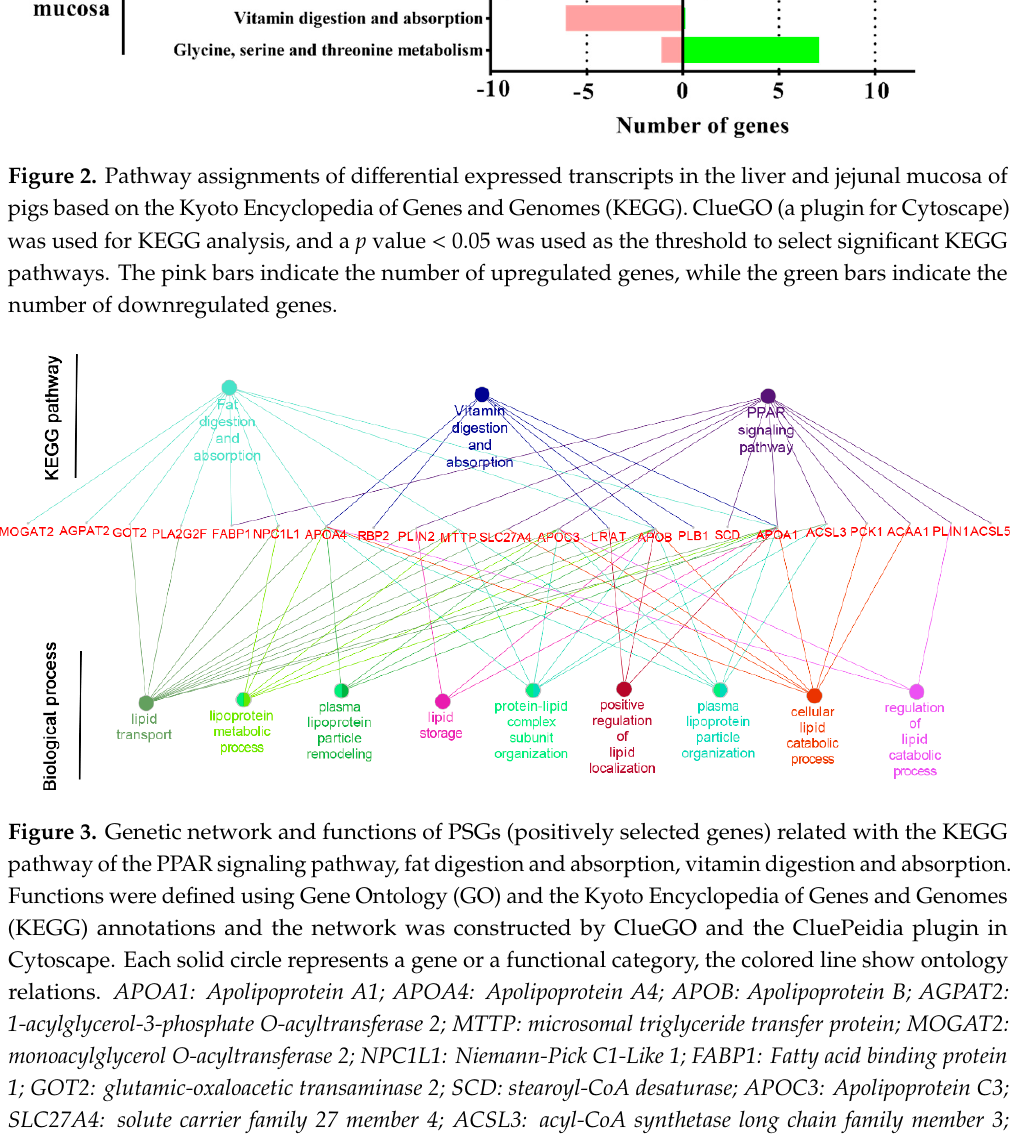
Phosphoenolpyruvate carboxykinase 1; PLIN1: Perilipin 1; PLIN2: Perilipin 2; PLA2G2F: phospholipase A2 group IIF; and PLB1: phospholipase